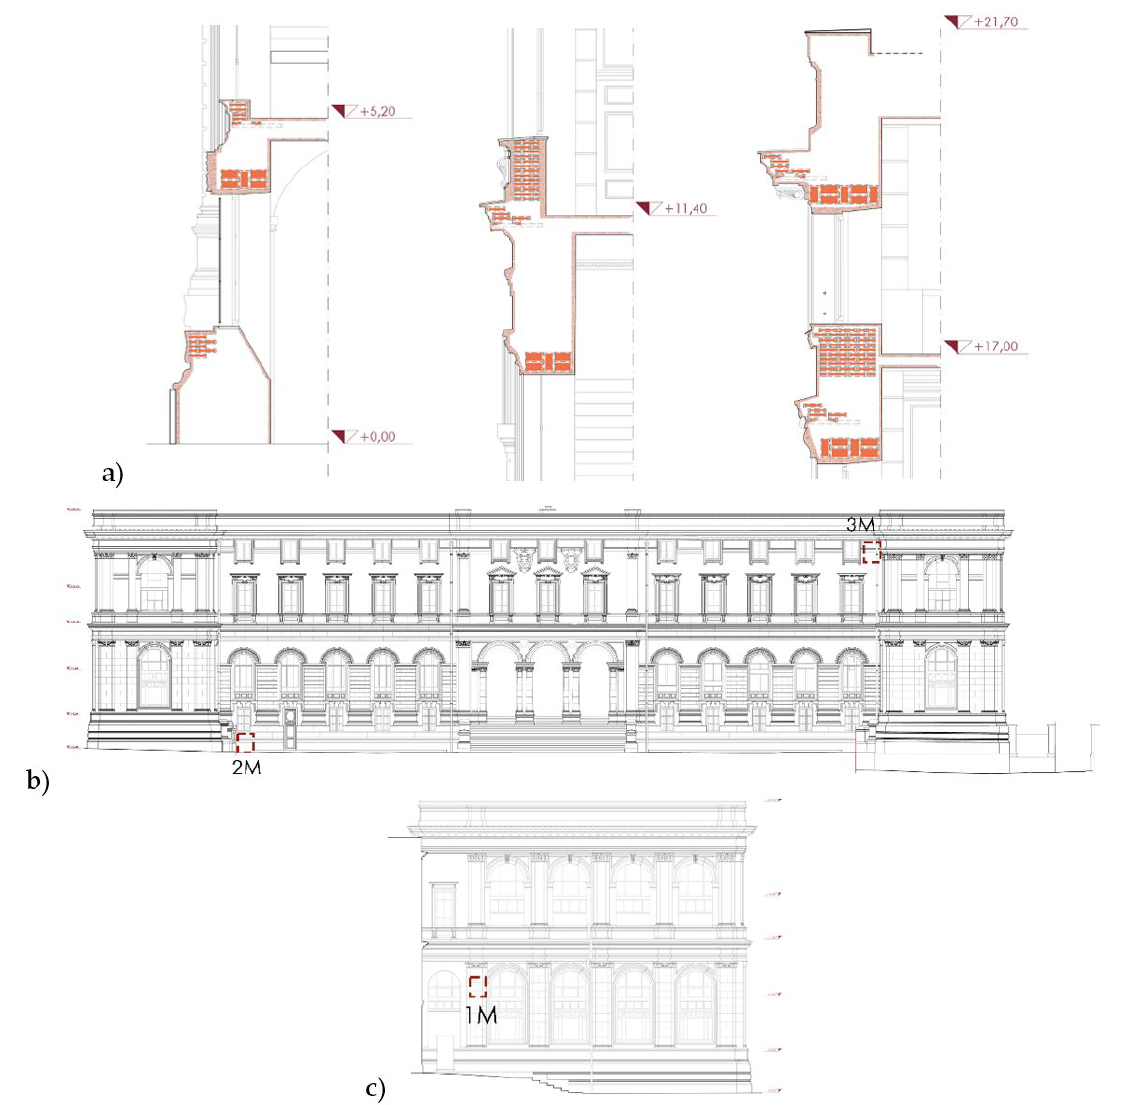
Figure 1. Case study. Investigated wall: Northern façade ( b ), Eastern façade ( c ) and particular of the stratigraphy ( a ). Table 1. Characteristics of the envelope.